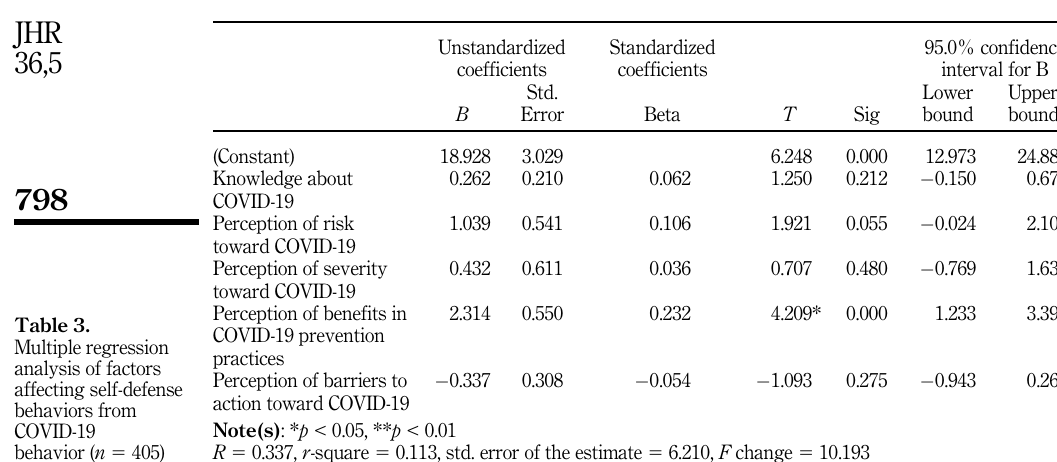
Table 3. Multiple regression analysis of factors affecting self-defense behaviors from